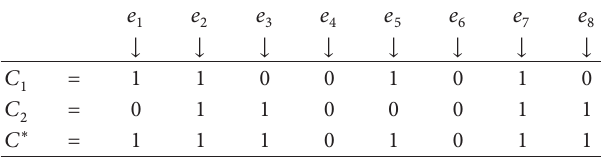
Table 1: Coverage pattern for 8 sampling